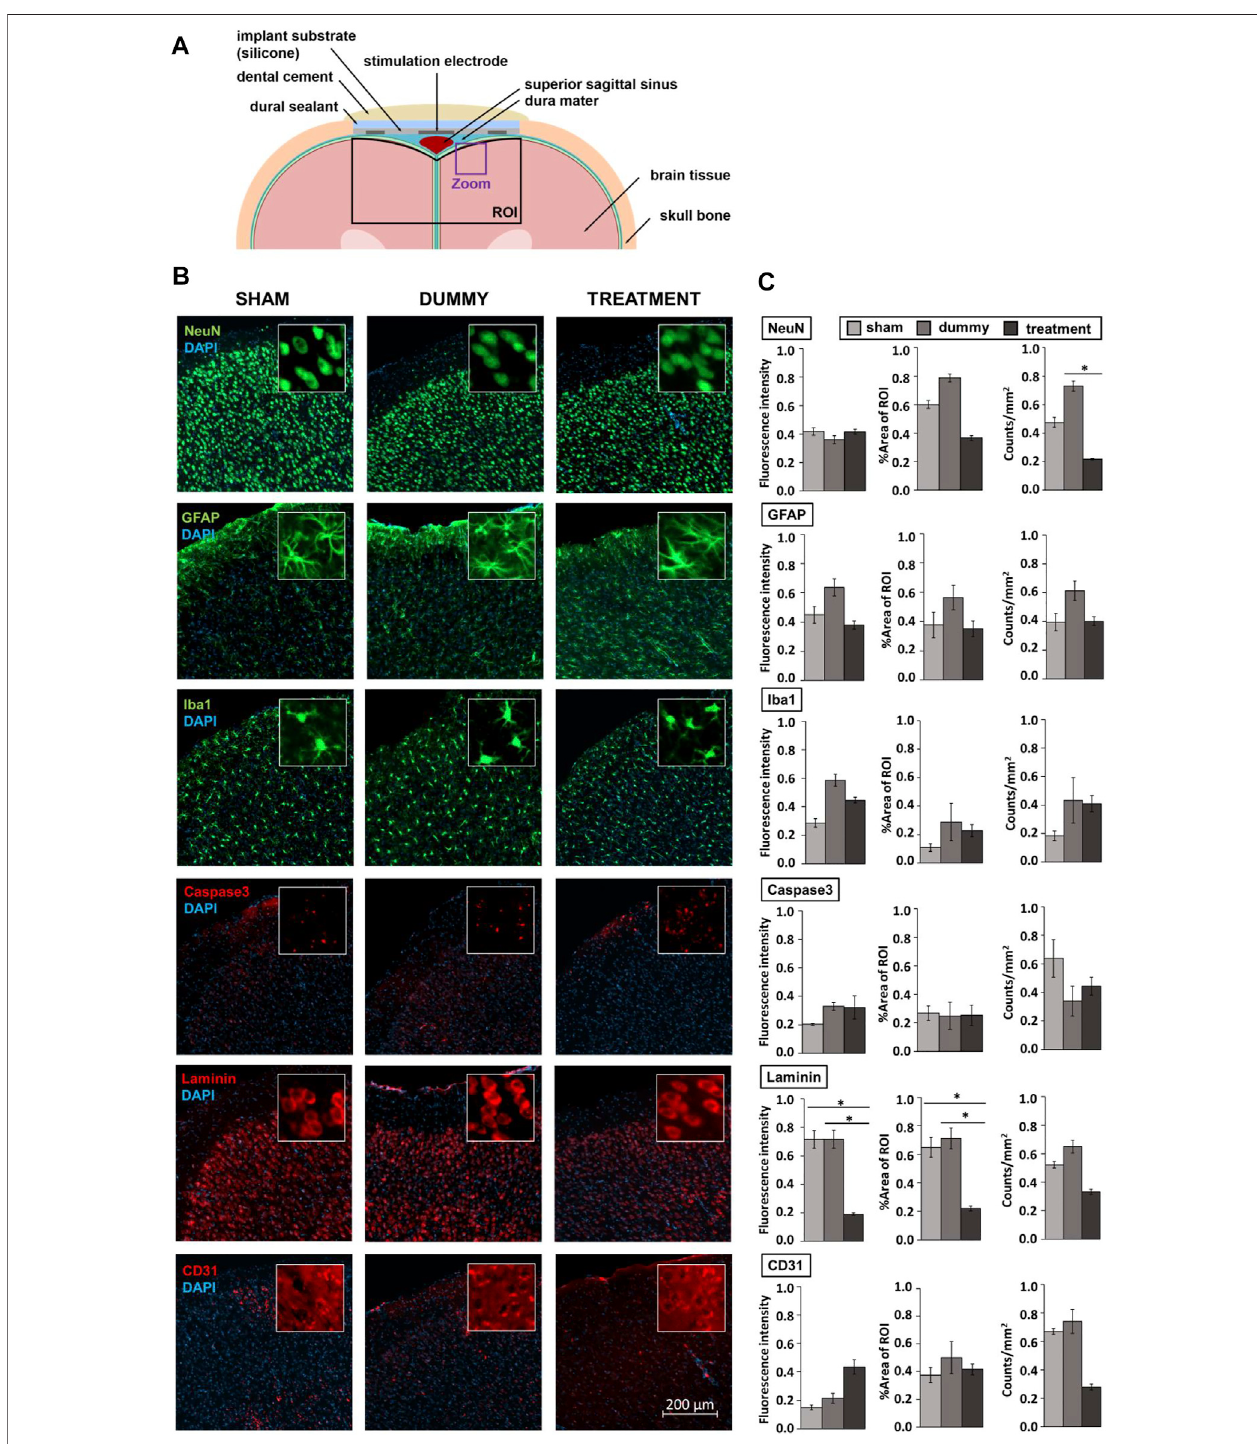
FIGURE 6 | Immunohistochemical evaluation of implant and treatment tissue response. (A) Cross-section of rat brain and the biomedical implant at 3.2 mm anterior to bregma including the region of interest (ROI) de fi ned for biocompatibility analysis following device explantation and the magni fi ed view presented in (B) . (B) Representative microscopic images of the left motor cortexat 3.2 mm anterior to bregma next tothe stimulation electrode. Insets are50 × 50 µm squares. (C) Selected biotoleranceindicatorsforeach,sixbrainslicesperstainingofsham-operatedanimals(n (cid:1) 3),ratsthatreceivedanimplantdummy(n (cid:1) 3)andtreatments(n (cid:1) 7)are normalized and presented as mean ± SEM. Asterisks indicate signi fi cant differences ( p < 0.05).